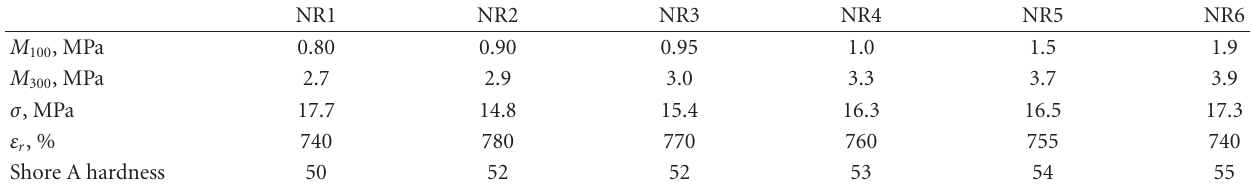
Table 3: Physicomechanical parameters of composites comprising fullerene.